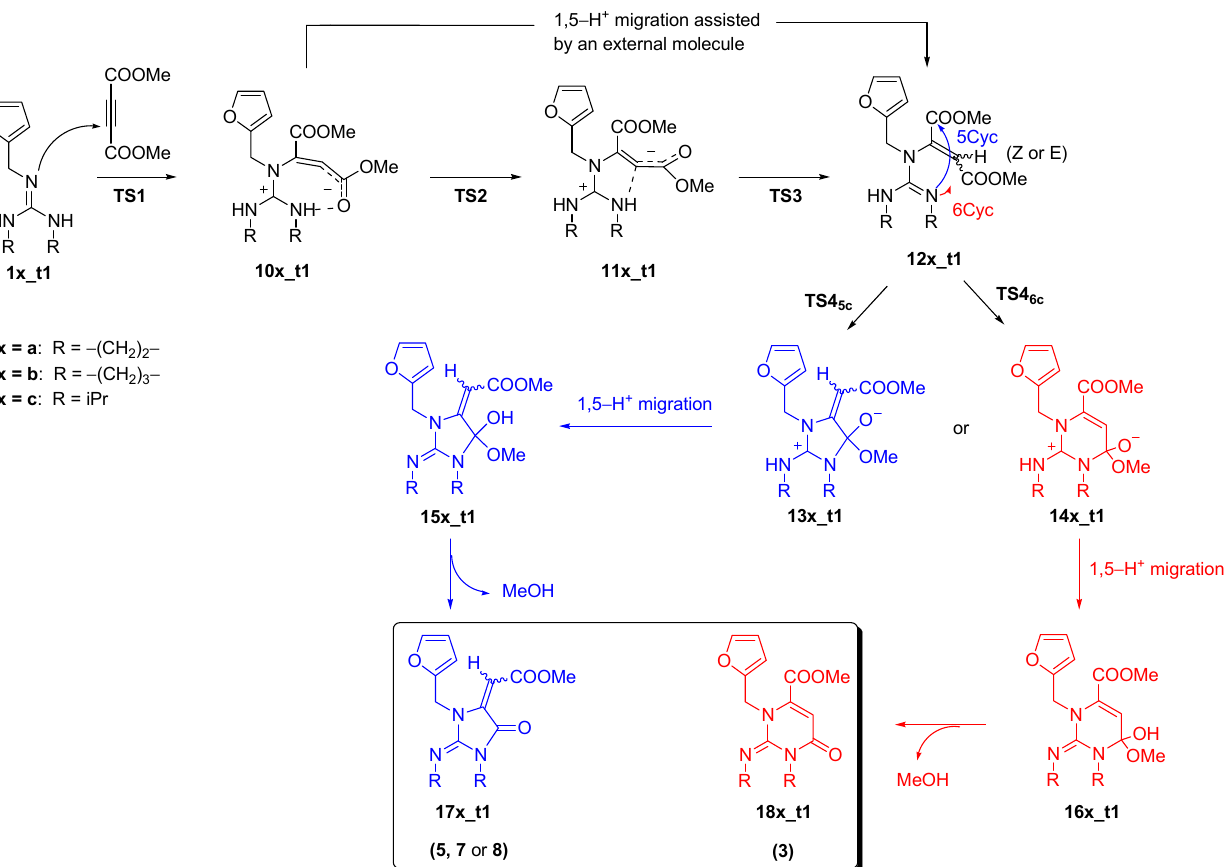
Figure 2. Reaction scheme and energetics for the formation of two possible tautomers by the hydro- gen chloride transfer from the guanidinium salt to DMAD . Relative energies of the tautomer M_t2 are given with respect to M_t1 . All energies are given in kJ mol − 1 . The results closest to the G3 values are given in blue